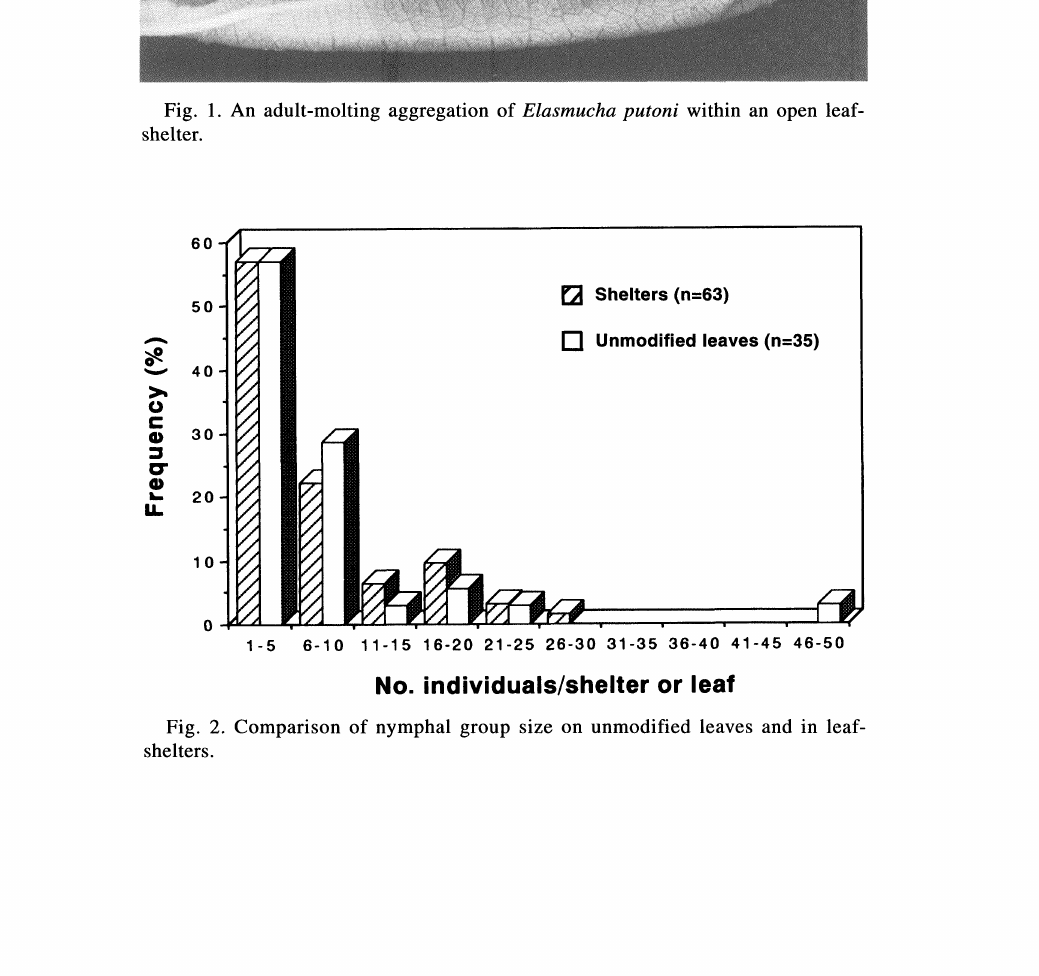
Fig. 2. Comparison of nymphal group size on unmodified leaves and in leaf-